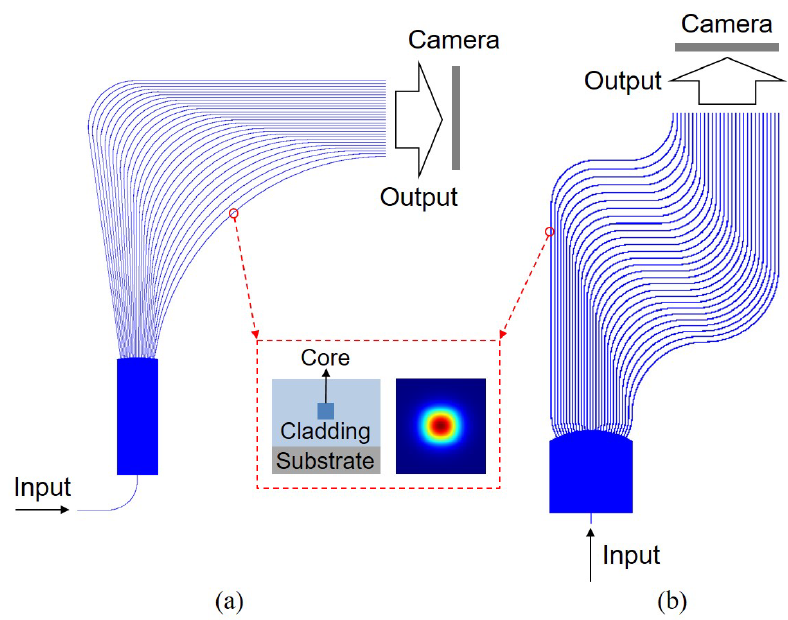
Figure 1. Schematics of WSLs with the waveguide array adopting the ( a ) one-arc and ( b ) three-arc structures to allow flexibility in setting length differences in the waveguide array. Figure 2 illustrates the wavelength separation and beam focusing functions of a